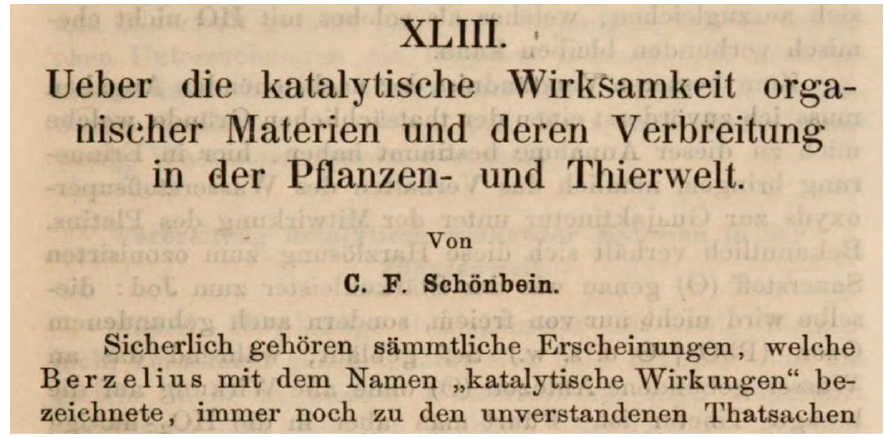
Figure 1. Copy of the title page of Schönbein’s article on the discovery of peroxidases [2]. In the introduction of his article, he characterizes the decomposition of hydrogen peroxide by living materials as a catalytic process and refers to the father of catalysis Jöns Jacob Berzelius (1779–1848).